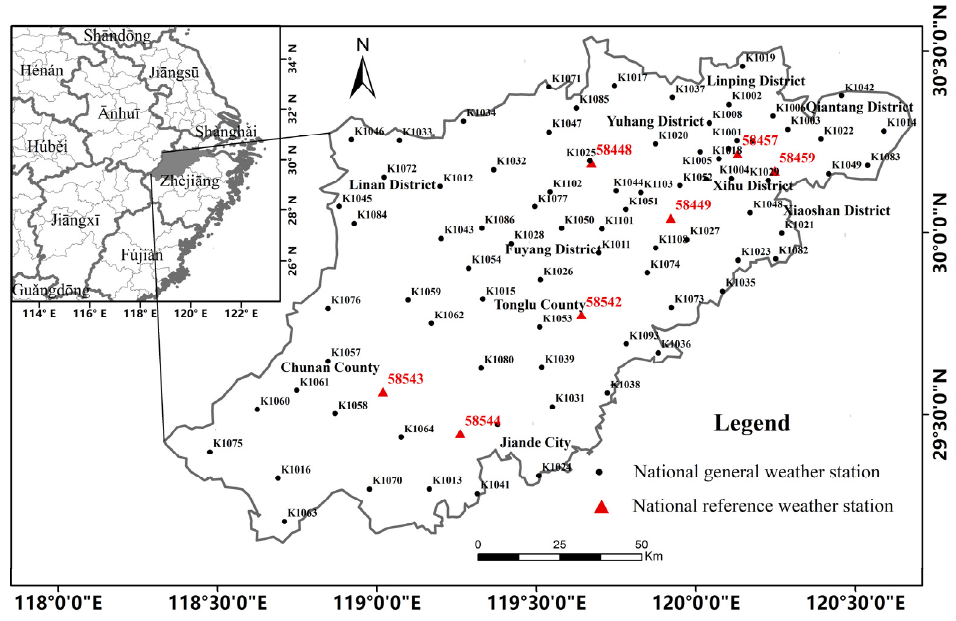
Figure 1. Distribution map of weather stations.